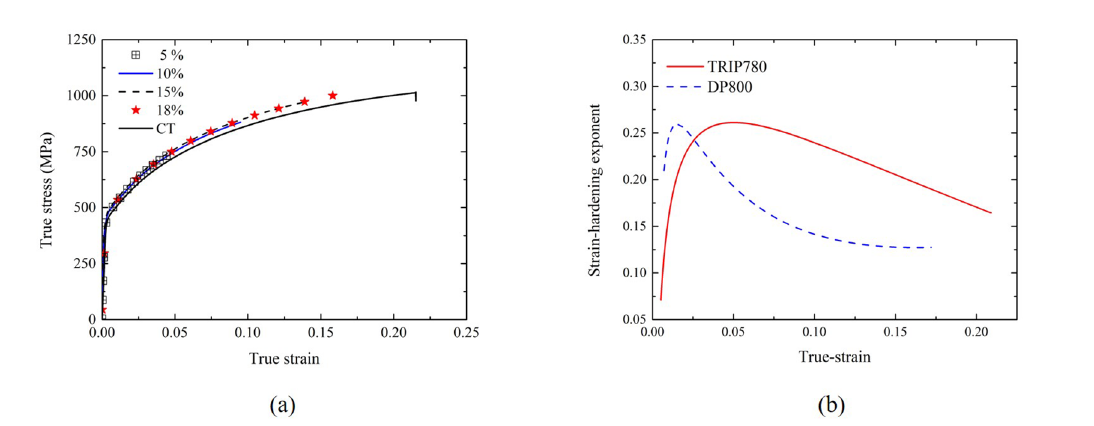
Figure 7. Uniaxial tensile mechanical behavior of the TRIP780 steel along the rolling direction: (a) interrupted and continuous tests and (b) instantaneous strain-hardening exponent compared with the plastic behavior of a similar AHSS